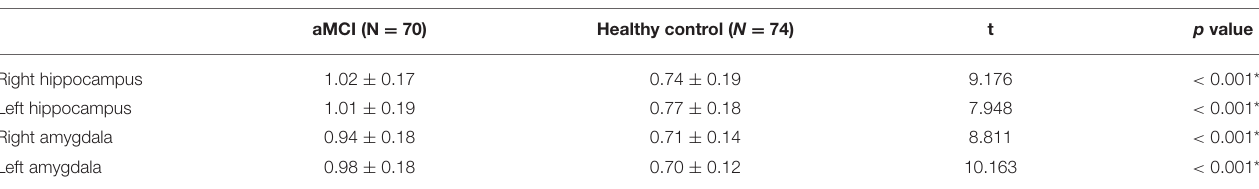
TABLE 2 | Comparison of APTw values between aMCI and healthy control